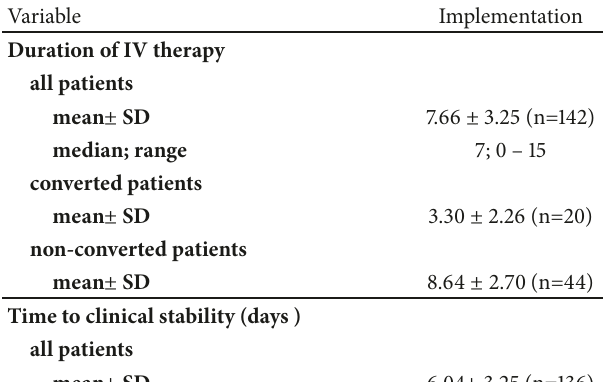
Table 3: Intravenous to oral antimicrobial therapy conversion outcomes at Jimma University Specialized Hospital, South